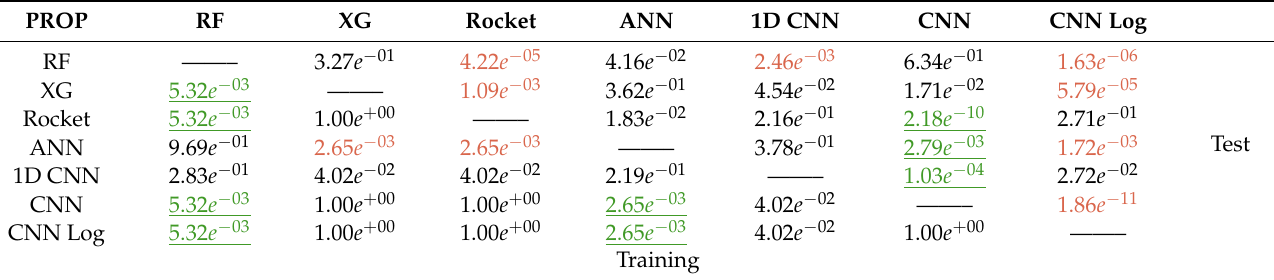
Table A6. Kruskal–Wallis p -values comparing all methods of the PROP concentration prediction task. Above the diagonal, we have the results for the test set, and below for the training set. Significant results ( p < 0.01) are represented in green or red when the method on the left is significantly better or worse, respectively.